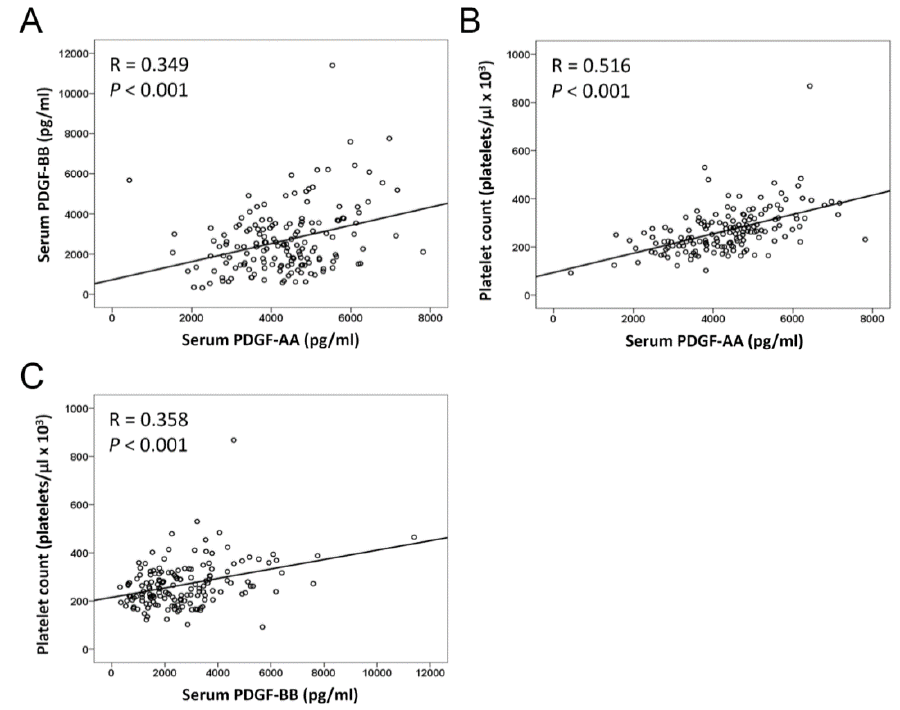
Figure 3. Correlation between preoperative serum PDGF-AA, PDGF-BB, and platelet count. ( A ) Serum PDGF-AA levels are significantly positive correlated with the expression levels of PDGF-BB. ( B , C ) Serum PDGF-AA and PDGF-BB correlate positively with platelet